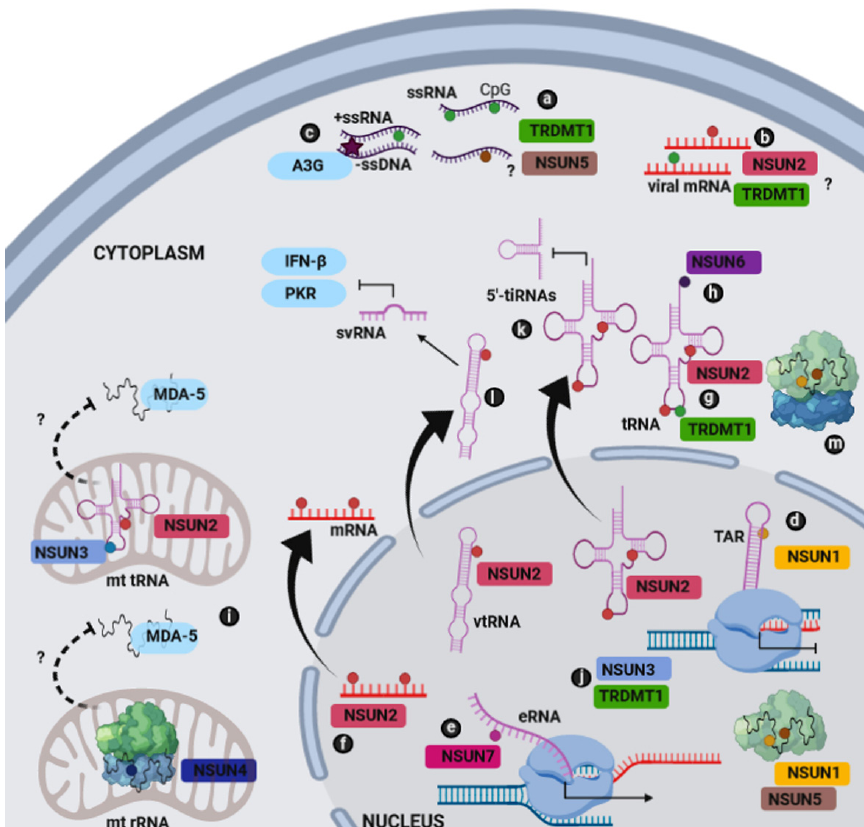
Figure 1. Overview of human m 5 C RNA methyltransferases and their RNA targets during viral infections. ( a ) The methylation of 5’C—phosphate—G3’ ( CpG) islands in viral genomic RNA by DNMT2 (TRDMT1) and perhaps NSUN5 may promote viral heterogeneity. ( b ) The modification of viral transcriptome by NSUN2 and perhaps TRDMT1 may result in increased transcript stability and efficient translation. ( c ) The cytosine deamination by A3G may lead to dC-to-dU conversions in viral (–)ssDNA that may cause G-to-A hypermutations in progeny viral genomes. ( d ) Induction of viral latency by NSUN1-mediated m 5 C methylation of TAR. ( e ) NSUN7-mediated m 5 C methylation of